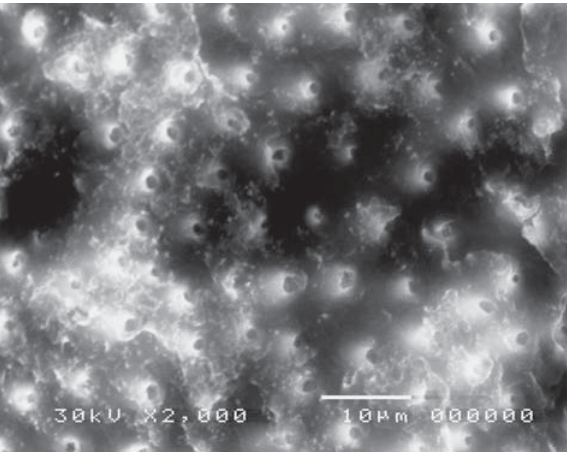
Figure 8- Electron-micrograph in control group (CL) after cavity (cid:83)(cid:85)(cid:72)(cid:83)(cid:68)(cid:85)(cid:68)(cid:87)(cid:76)(cid:82)(cid:81)(cid:3)(cid:90)(cid:76)(cid:87)(cid:75)(cid:3)(cid:79)(cid:68)(cid:86)(cid:72)(cid:85)(cid:3)(cid:86)(cid:75)(cid:82)(cid:90)(cid:76)(cid:81)(cid:74)(cid:3)(cid:70)(cid:82)(cid:81)(cid:192)(cid:88)(cid:72)(cid:81)(cid:70)(cid:72)(cid:3)(cid:82)(cid:73)(cid:3)(cid:87)(cid:88)(cid:69)(cid:88)(cid:79)(cid:68)(cid:85)(cid:3)(cid:68)(cid:81)(cid:71)(cid:3)(cid:76)(cid:81)(cid:87)(cid:72)(cid:85)(cid:16) tubular structures in some areas. Irregular inter-lacing collagen (cid:191)(cid:69)(cid:72)(cid:85)(cid:86)(cid:15)(cid:3)(cid:68)(cid:81)(cid:71)(cid:3)(cid:83)(cid:68)(cid:85)(cid:87)(cid:76)(cid:68)(cid:79)(cid:79)(cid:92)(cid:3)(cid:82)(cid:69)(cid:79)(cid:76)(cid:87)(cid:72)(cid:85)(cid:68)(cid:87)(cid:72)(cid:71)(cid:3)(cid:71)(cid:72)(cid:81)(cid:87)(cid:76)(cid:81)(cid:68)(cid:79)(cid:3)(cid:87)(cid:88)(cid:69)(cid:88)(cid:79)(cid:72)(cid:86)(cid:3)(cid:68)(cid:85)(cid:72)(cid:3)(cid:68)(cid:79)(cid:86)(cid:82)(cid:3)(cid:81)(cid:82)(cid:87)(cid:72)(cid:71)(cid:3) (x500)